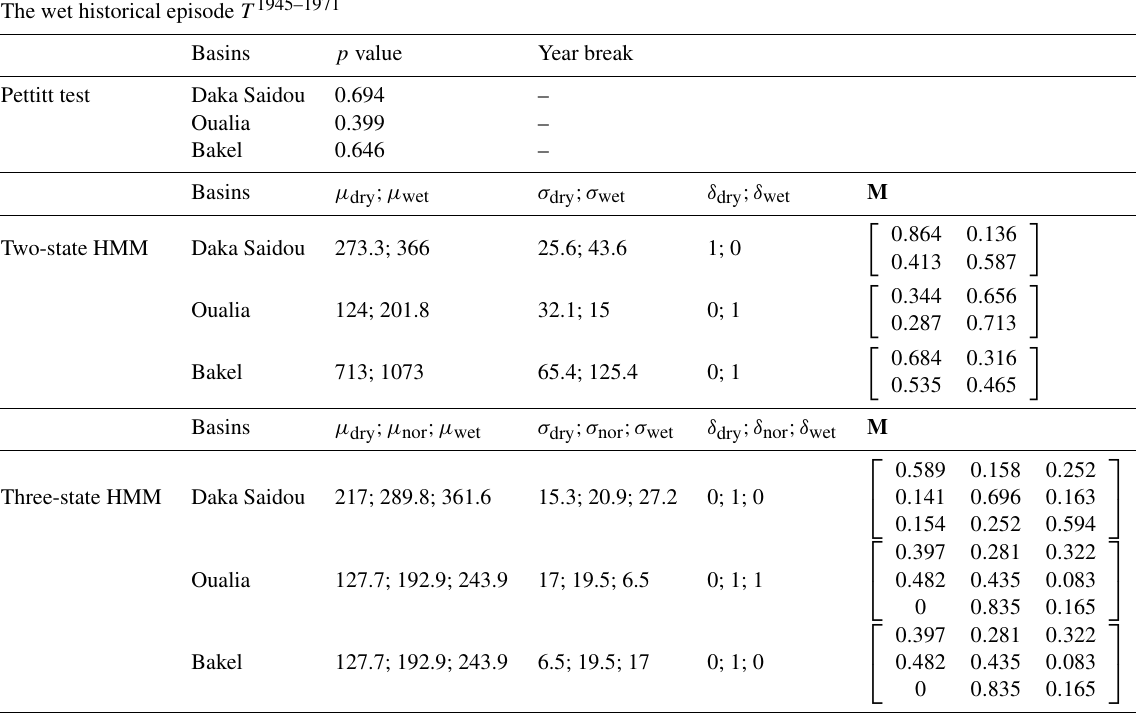
Table 4. Pettitt test results and hidden Markov model parameters ( N = 2 and N = 3) for Daka Saidou, Oualia, and Bakel sub-basins, on the wet subsequence T 1945–1971 .